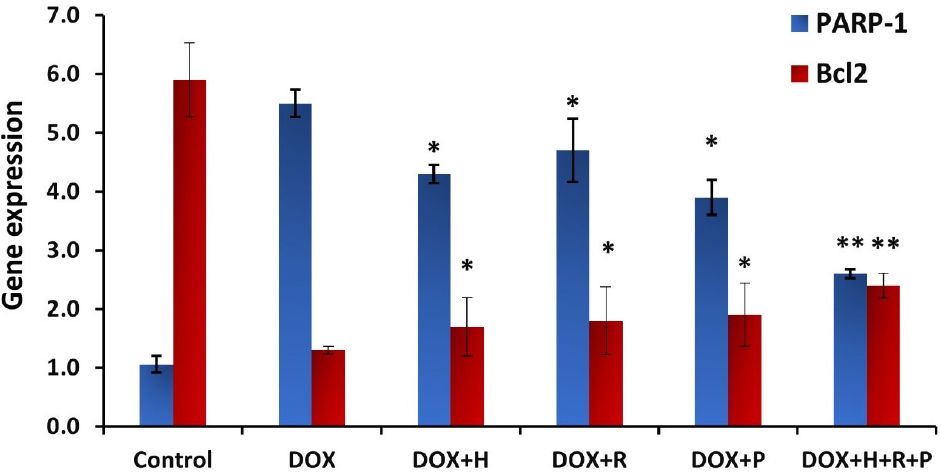
Figure 6. Histogram for poly (ADP-ribose) polymerase 1 (PARP-1) and Bcl2 genes expression in response to treatment with honey (H), propolis (P), and royal jelly (R) mix (H + P + R) on rats treated with Doxorubicin. The groups are negative control; Dox treated group (Dox); the Dox +hony treated group (Dox + H); the Dox + royal jelly treated group (Dox + R); the Dox +propolis treated group (Dox + P); the Dox + mix of honey, royal jelly, and propolis treated group (Dox + H + P + R). * mean significant p ‐ value less than 0.05. ** mean significant p ‐ value less than 0.01.